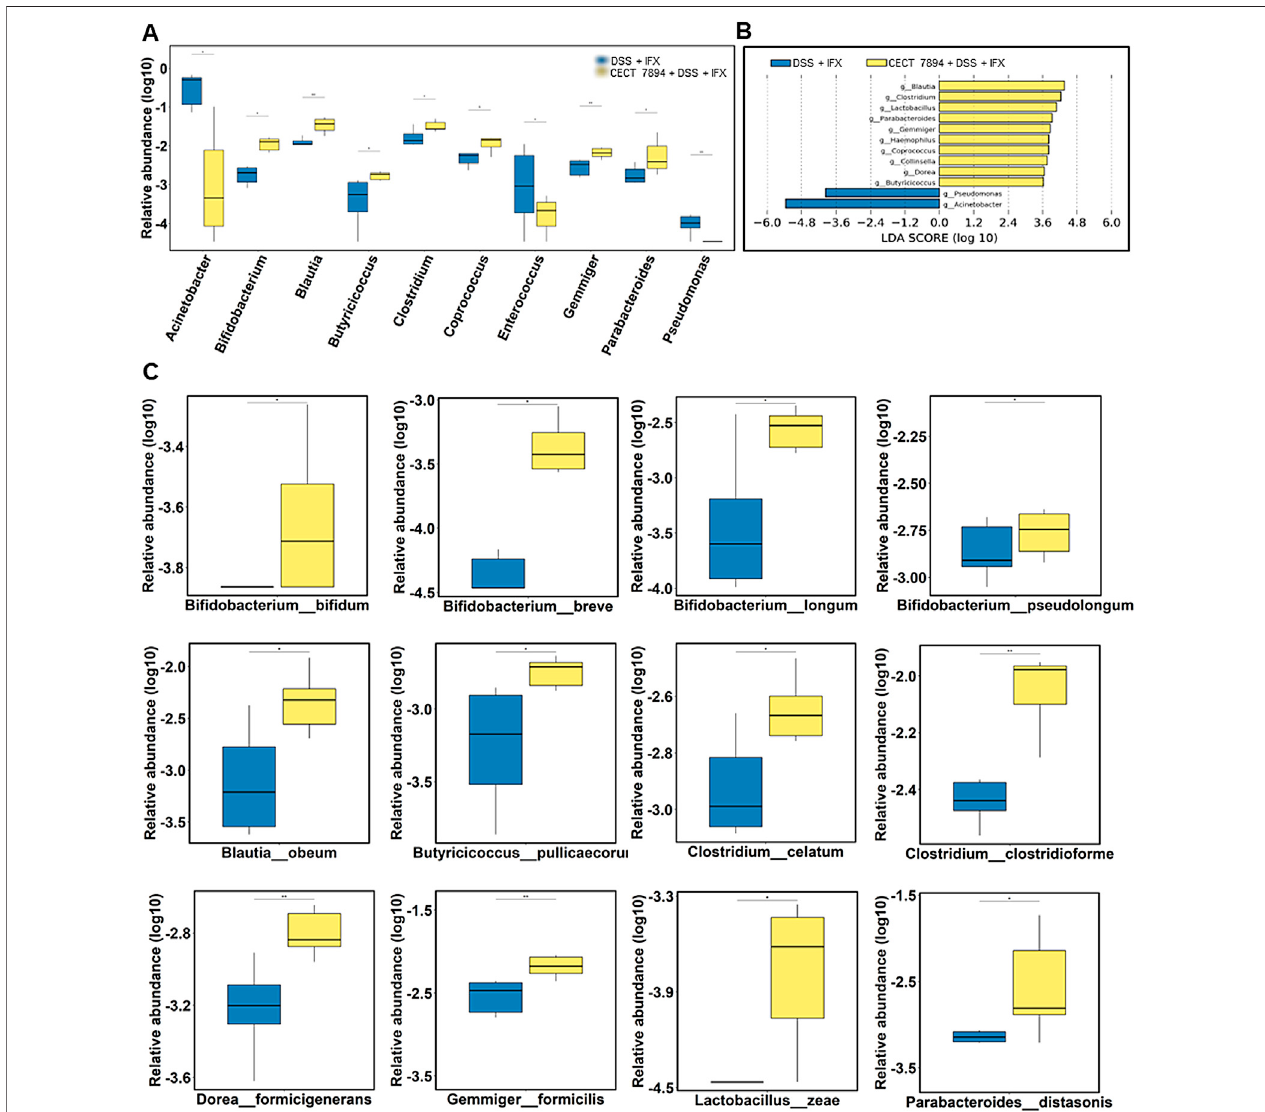
FIGURE 4 | B. longum CECT 7894 modi fi es the gut microbiota composition. (A) Relative abundance of bacteria at the genera levels. (B) The LEfSe identi fi ed the taxa with the greatest differences in the abundance of genera between the DSS + IFX group and B. longum CECT 7894 + DSS + IFX group. (C) Relative abundance of bacteria at the species levels. Statistical signi fi cance was assessed by using Wilcoxon rank-sum test. * p ≤ 0.05, ** p ≤ 0.01.